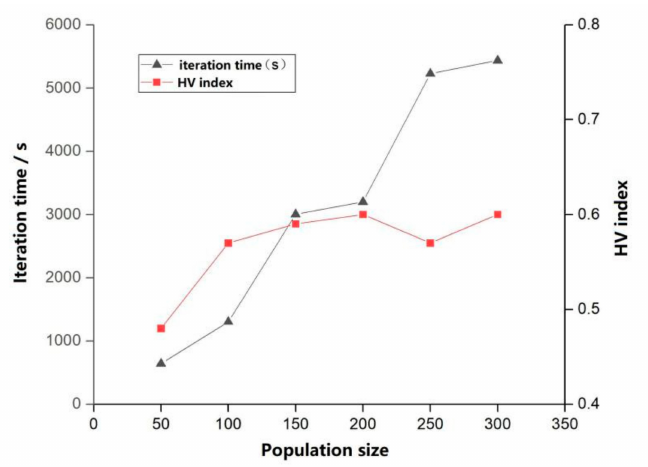
Figure 12. Effects of different population sizes on HV and iteration